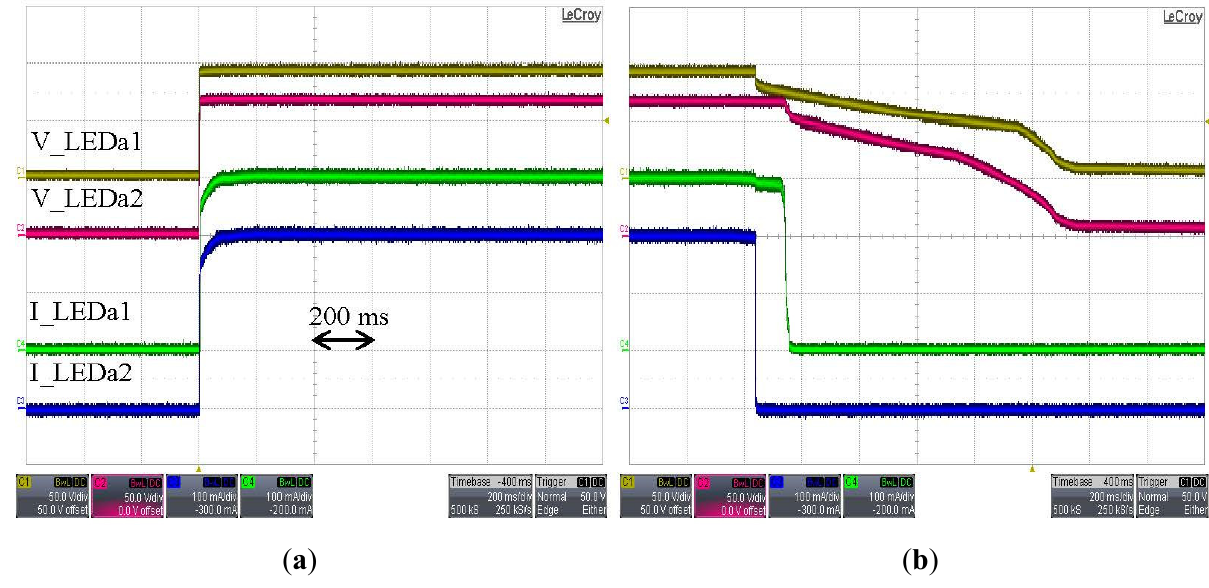
Figure 22. LED voltage and current in the case where the converter is turned on and off. ( a ) Turn on; ( b ) Turn